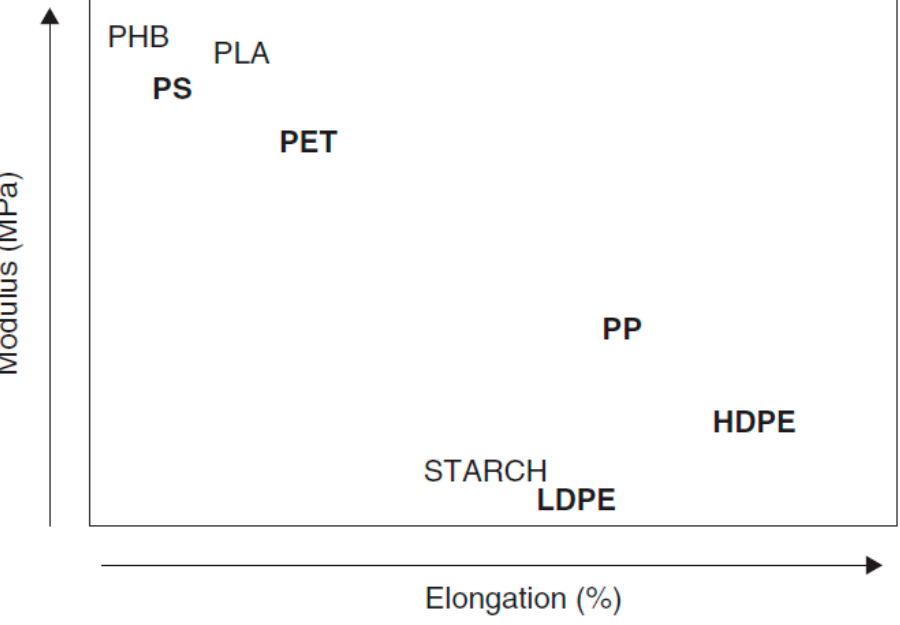
Figure 5. Mechanical properties of biopolymers and fossil-based polymers [28].